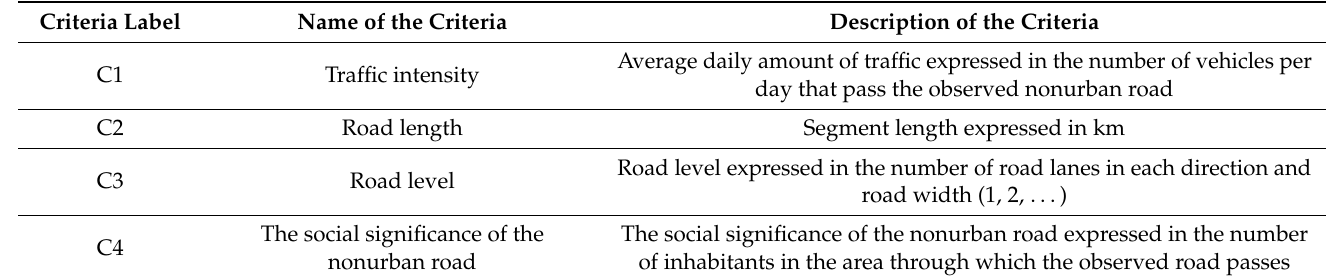
Figure 3. Representation of the regional roads in Herzegovina-Neretva County [21]. Table 1. List and description of criteria for evaluating the nonurban roads